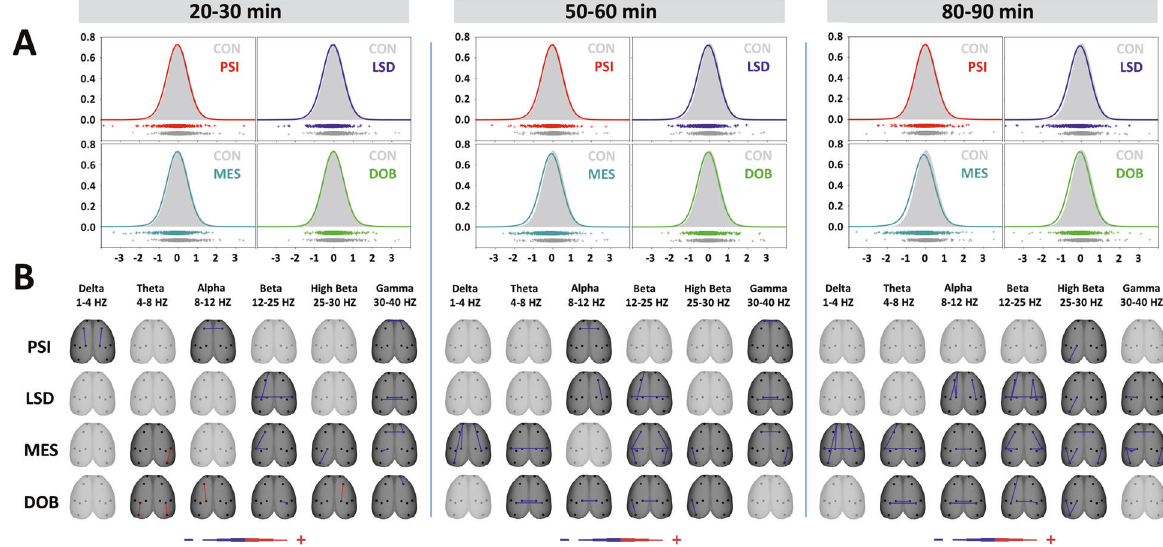
Fig. 3 The effects of treatments on cross-spectral coherence in three time epochs. A Global cross-spectral coherence connectivity. Each fi gure contains estimated probability distributions of connectivity in a sense + / − (increase decrease) following drug treatment (solid line) vs control ( fi lled area) condition. The curve is representing the reduced dimensionality of global connectivity generated from all coherence between all electrode pairs across all frequency bands and all animals into 2D space. A negative or positive change of global functional connectivity in a drug condition is indicated by its shifted distribution toward negative or positive values with respect to the control condition. In the scatterplots below each graph, each individual dot represents one value of individual functional connectivity of one subject/ electrode pair/in a de fi ned frequency band obtained by the Kernel Density Estimator (KDE). CON (control group, saline 2 ml/kg, gray), PSI (psilocin, 4 mg/kg, red), LSD (lysergic acid diethylamide 0.2 mg/kg, blue), MES (mescaline 100 mg/kg, teal), DOB 5 (2,5-dimethoxy-4- bromoamphetamine, 5 mg/kg, green). B , EEG cross-spectral coherence topographic maps — all treatments compared against the control group, drugs in rows, frequency bands in columns; Only signi fi cant change is displayed ( P < 0.05), the direction of change is indicated by the color — decrease in blue, increase in red. The level of relative difference is indicated by a three-level-scaled line width < − 3, − 2, − 1, 1, 2, 3 > , see the